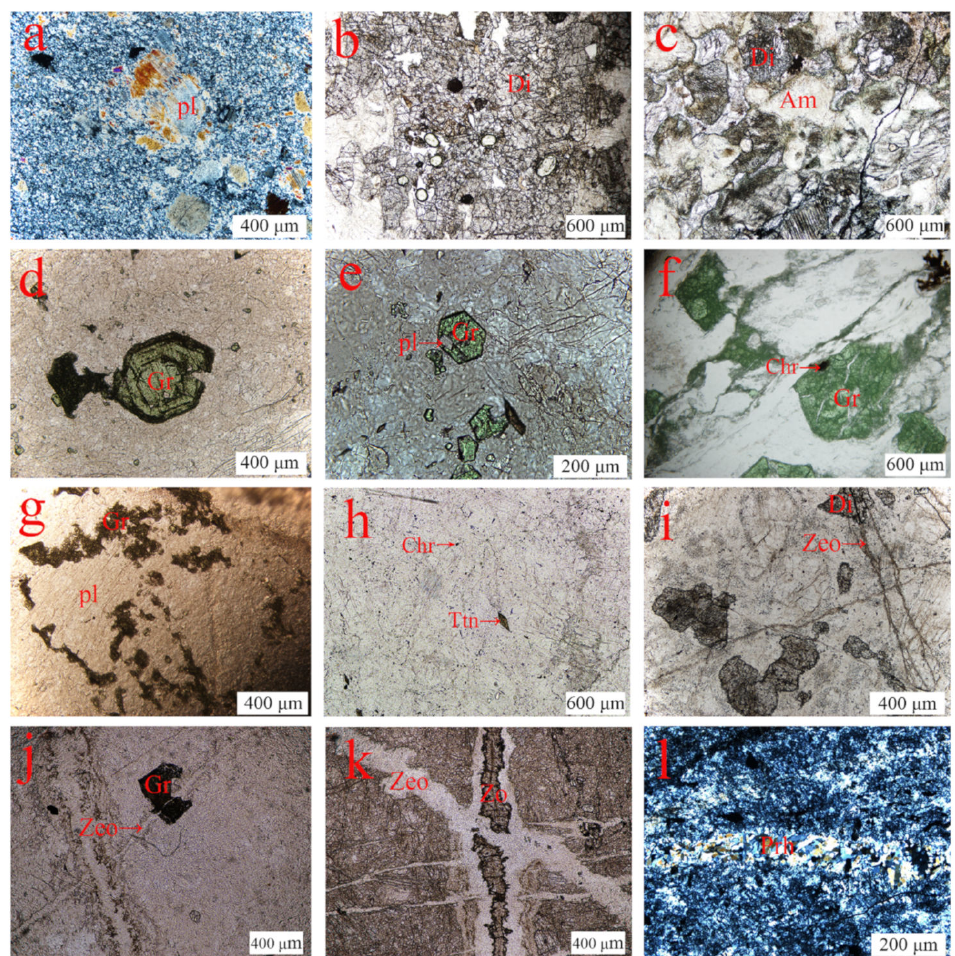
Figure 3. Mineral microstructural characteristics and paragenetic relationships of the samples under polarized light microscope (PLM). ( a ) The fractured plagioclase phenocryst surrounded by small plagioclase grains (Q-1); ( b ) the granular and short columnar diopside (Q-5); ( c ) the amphibole- supergroup mineral and the altered diopside (Q-7); ( d ) growth zones of the garnet-supergroup mineral (Q-4); ( e ) the fine-grained plagioclase as inclusions in the garnet-supergroup mineral (Q-4); ( f ) the chromite as inclusions in the garnet-supergroup mineral (Q-2); ( g ) the plagioclase phenocryst surrounded by small granular garnet-supergroup mineral (Q-3); ( h ) granular chromite and rhombic titanite (Q-8); ( i ) the zeolite vein cutting across the diopside (Q-6); ( j ) the zeolite vein cutting across the garnet-supergroup mineral (Q-3); ( k ) the zeolite vein cutting across the zoisite vein (Q-3); ( l ) the “mosaic”-like prehnite vein (Q-3). Pl, major mineral plagioclase; Di, minor minerals diopside; Am, amphibole-supergroup mineral; Gr, garnet-supergroup mineral; Chr, chromite; Ttn, titanite; Zeo, zeolite; Prh, prehnite; Zo,